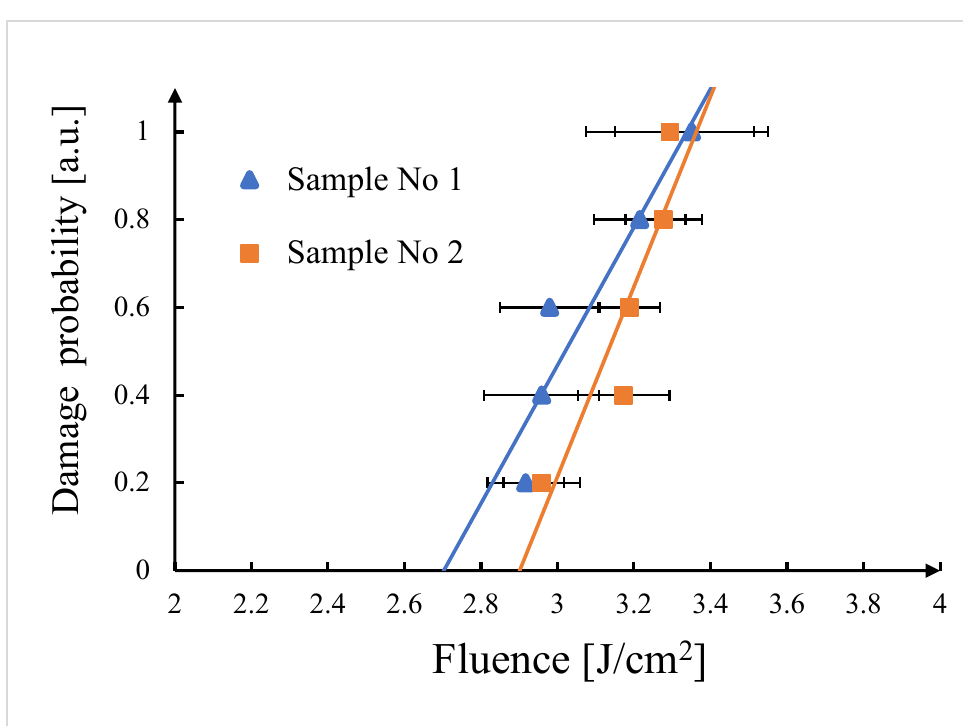
Figure 5. Dependence of the optical breakdown probability of samples No. 1 ( ∆ ) and No. 2 ( (cid:3) ) on the energy density of the incident laser radiation.